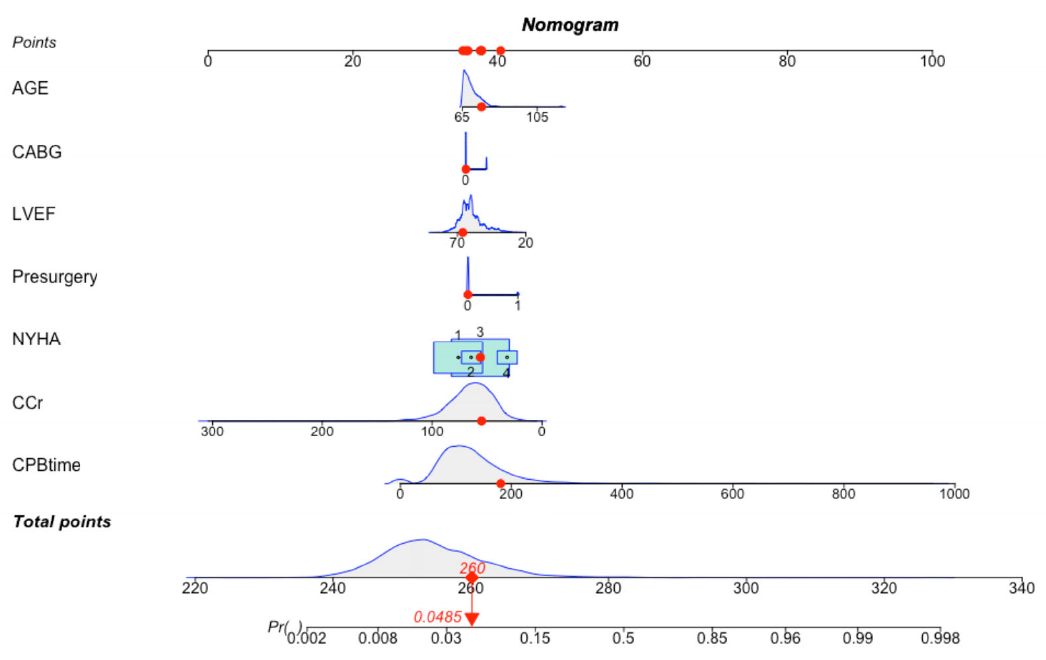
Figure 7. One example of nomogram. Enter the values of 7 key variables to predict the risk of in-hospital mortality and show the contribution of each value to the outcome.